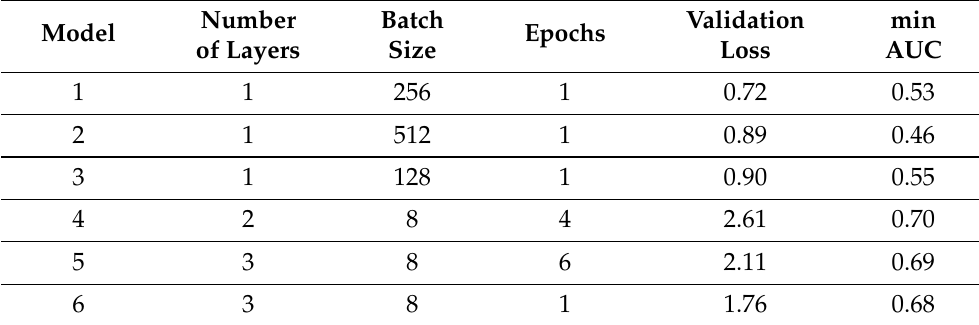
Table 17. Description of chosen models based on the validation loss and the highest minimal AUC